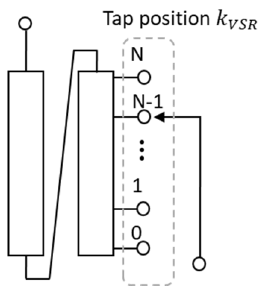
Figure 5. Winding arrangement of a VSR